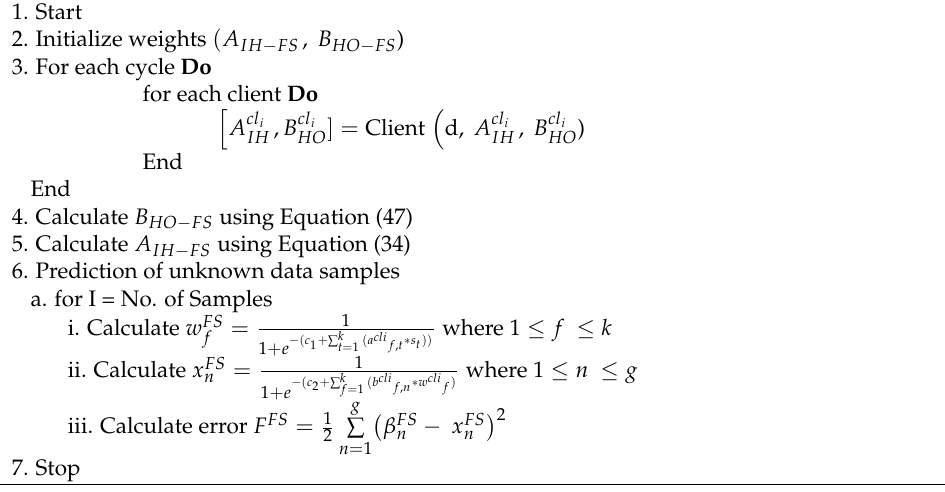
Table 2. Proposed weighted federated machine learning algorithm pseudo code.